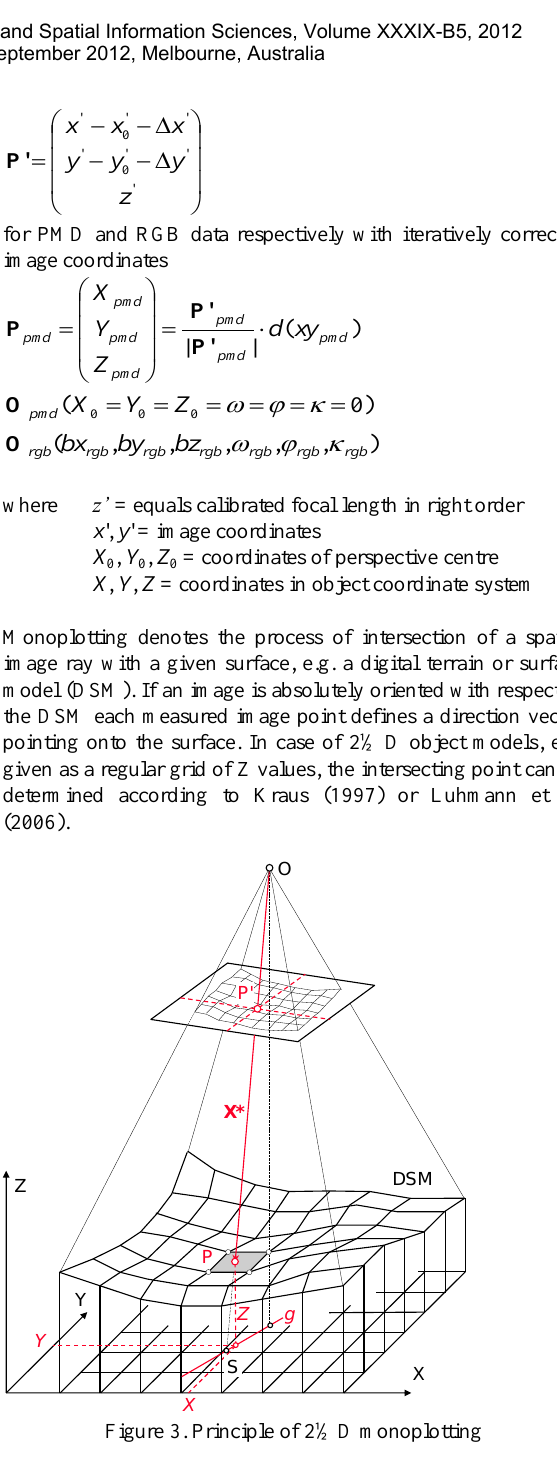
Figure 3. Principle of 2½ D monoplotting The spatial direction defined by the measured image coordinates x ', y ', z' in the image coordinate system (image vector x' ) is transformed into the spatial vector X * using the exterior orientation parameters (similarity transform with arbitrary scale, e.g. m = 1). This ray intersects the DSM at point P using a local surface plane defined by the four adjacent points. In order to calculate the point of intersection, the straight line g is constructed between the intersection point S of X * and the XY plane, and the foot of the perpendicular O XY from the perspective centre to the XY plane. A search for point P starts along this line at O XY until its interpolated height Z lie within two Z values of adjacent profile points. Figure 3 illustrates the principle of 2½ D